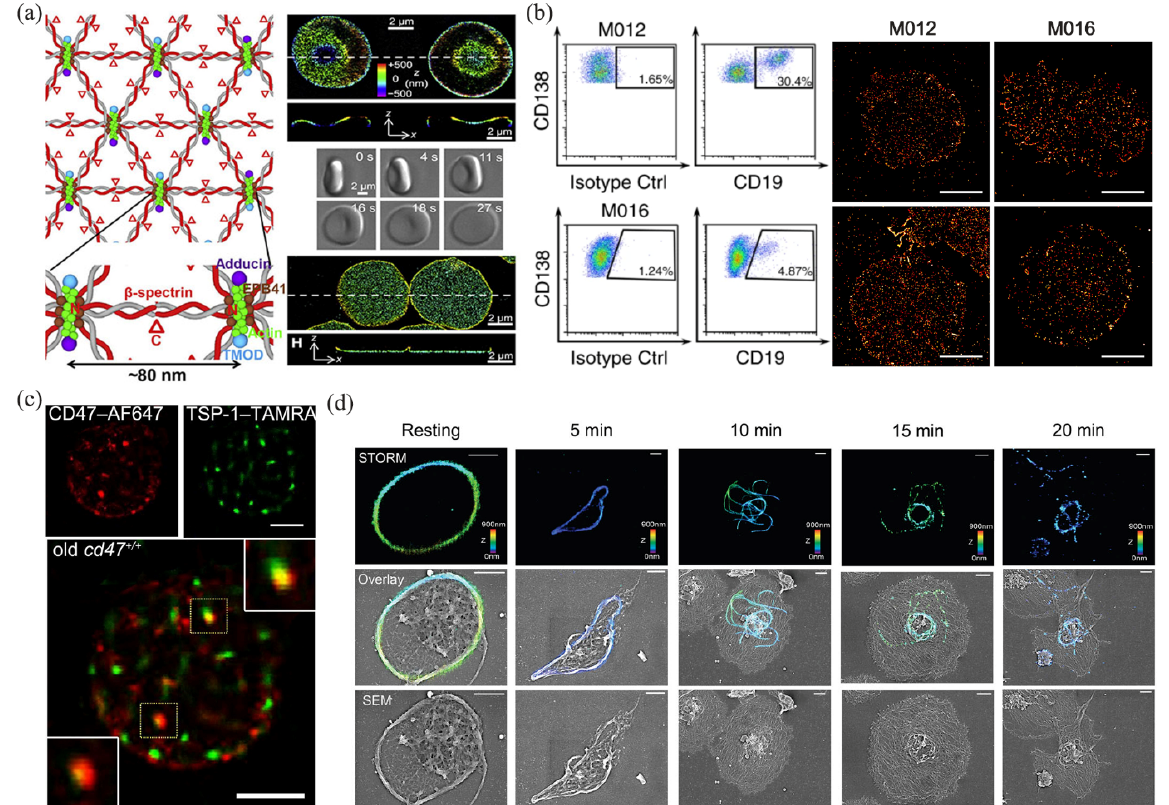
Figure 2. Applications of SMLM in blood cell analysis. ( a ) The ultrastructure of erythrocyte membrane skeleton revealed by STORM. Reprinted from [66]. ( b ) Detection and analysis of CD19 in multiple myeloma cells by dSTORM and flow cytometry. Reprinted from [40]. ( c ) Colocalization of TSP-1 and CD47 in aging erythrocytes by two-color dSTORM. Reprinted from [67]. ( d ) STORM and SEM images of microtubules in platelets. Reprinted from [68].